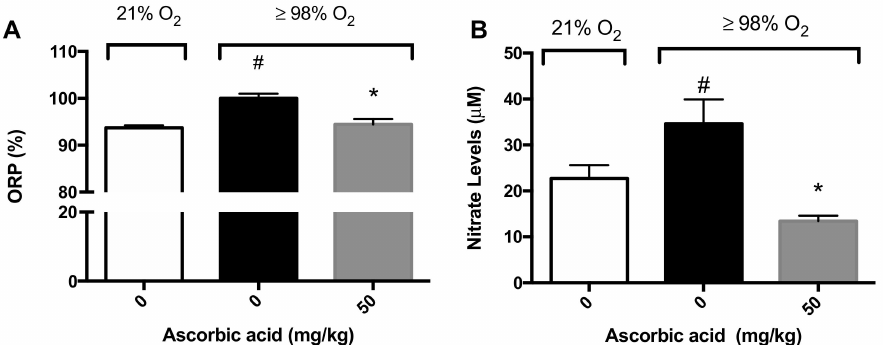
Figure 6. Ascorbic Acid (AA) attenuates hyperoxia-induced oxidative stress in lungs. Mice were exposed to ≥ 98% O 2 or 21% O 2 for 72 h and randomized to receive either ascorbic acid (50 mg / kg i.p. ) or saline. Mice were sacrificed and BALF was harvested and the oxidation-reduction potential (ORP) was determined ( A ) ( n = 8–11 each group) and nitrite levels ( B ) ( n = 8–11 each group). The data represent the mean ± SEM of three independent experiments. * p ≤ 0.05 compared to 98% O 2 control mice. # p ≤ 0.05 compared to 21% O 2 control